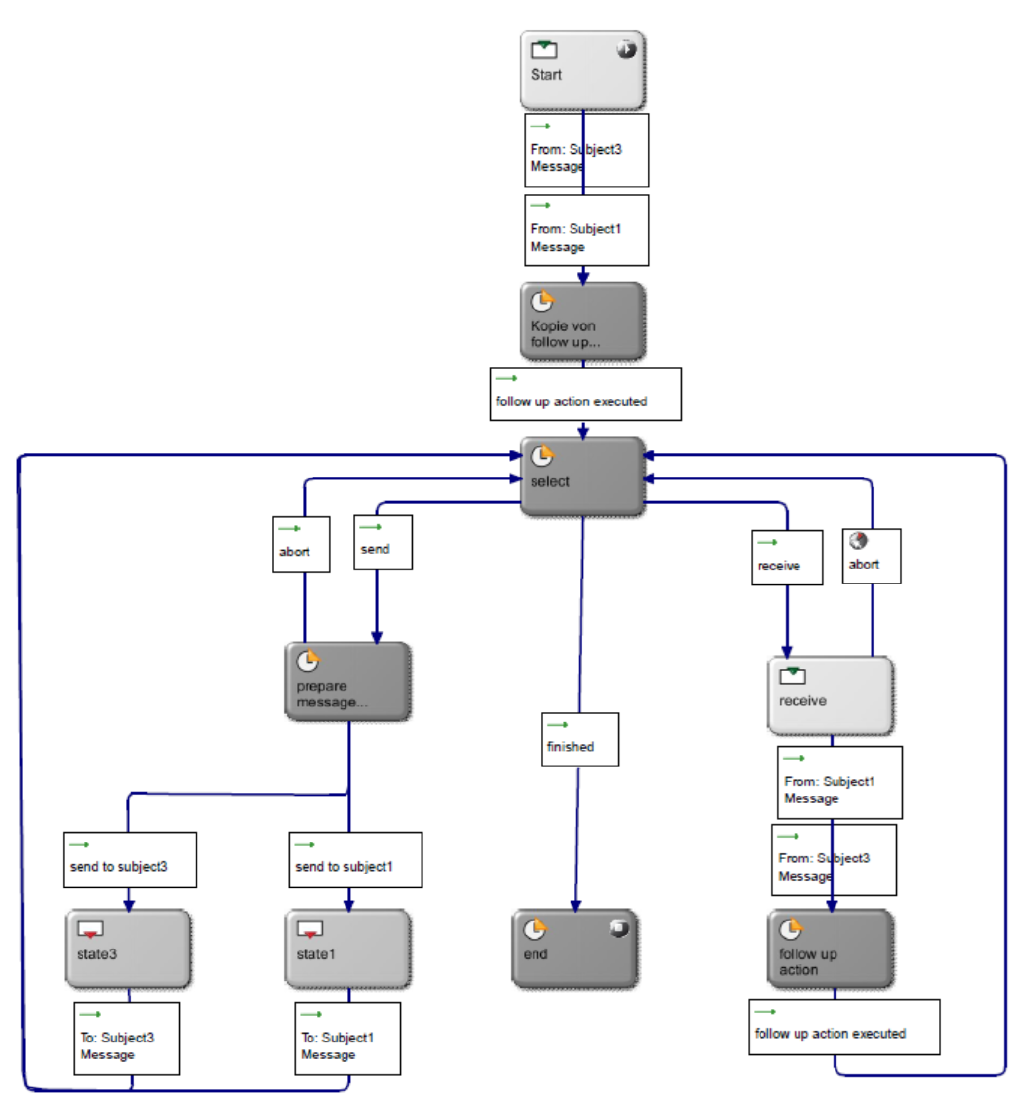
Figure 8. Generic behavior of